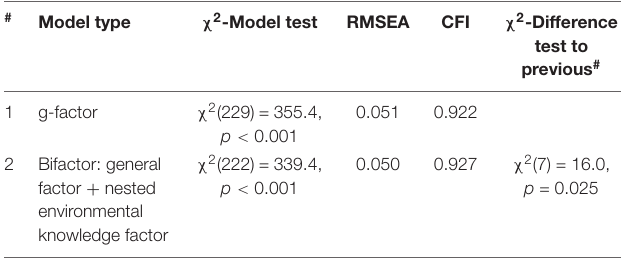
TABLE 3 | Model comparisons of general knowledge structure (indicators are parcels; parcel n = 16 + 7), including vs. excluding environmental knowledge as specific factor.